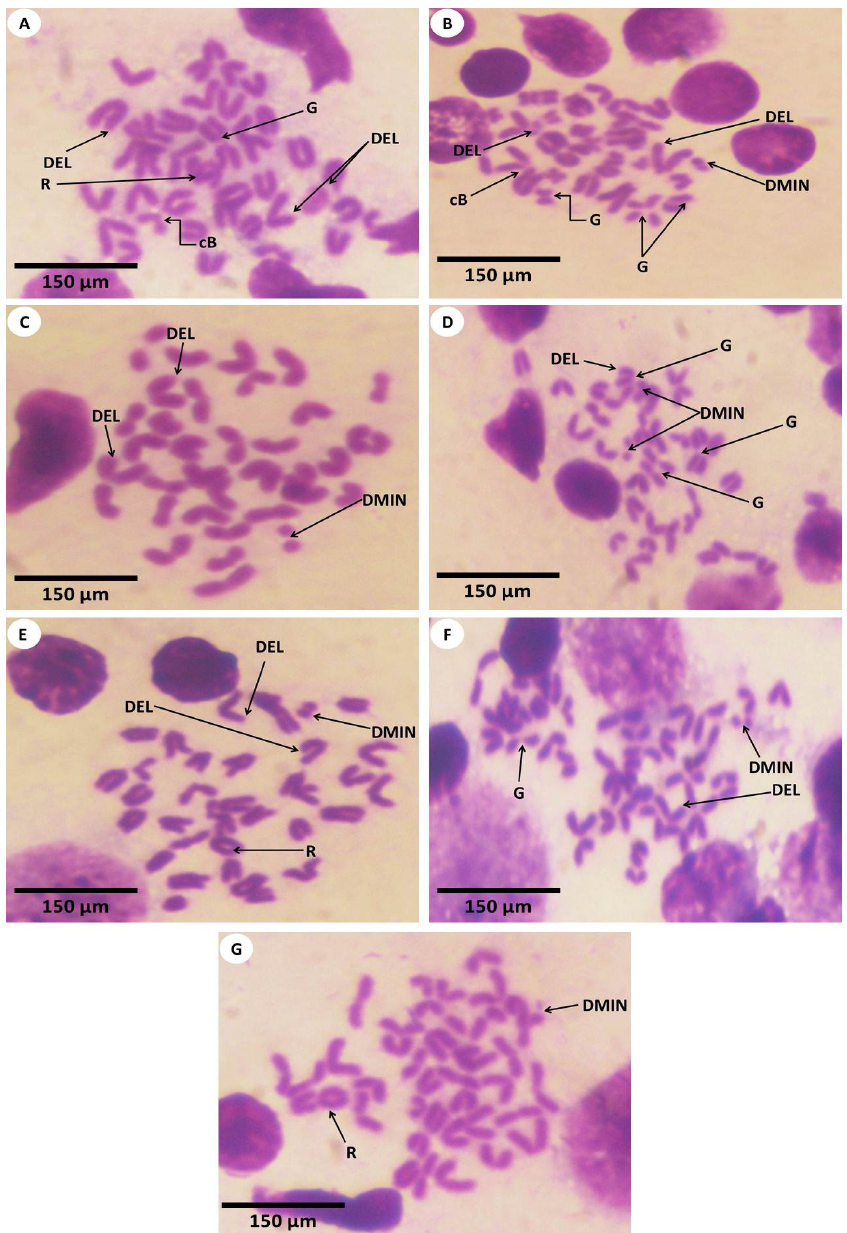
Figure 11. Metaphase smear of different bone marrow cells of mice’s femurs and humeral bones (Giemsa, 1500×) that were presented in the following figures: ( A – D ) exhibited abnormalities of chromosomes from mice that were exposed to Fe 2 O 3 -NPs (third group) and that displayed the deletion of chromosomes (DEL), a chromatid gap (G), double minute chromosomes (DMIN), a break of chromatid (cB), and ring chromosomes (R). In addition, the ( E – G ) figures from Fe 2 O 3 -NPs plus PPE-treated mice (fourth group) showed ring chromosomes (R), the deletion of chromosome (DEL), double minute chromosomes (DMIN), and a chromatid gap (G).